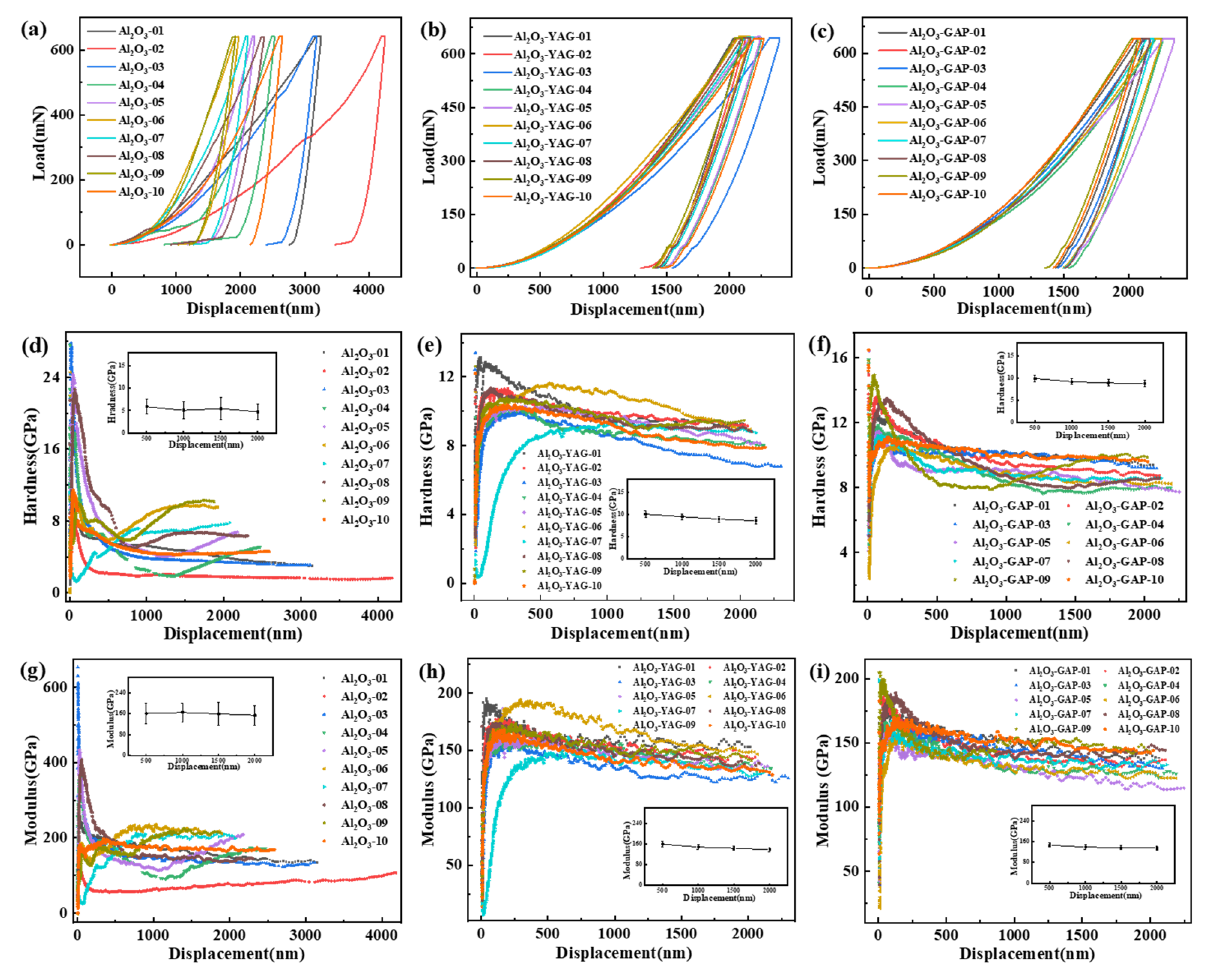
Figure 5. The load–displacement ( a – c ), hardness–displacement ( d – f ) and modulus–displacement ( g – i ) curves of the Al 2 O 3 , Al 2 O 3 -YAG and Al 2 O 3 -GAP coatings. Table 4. The nanoindentation hardness and elastic modulus of several coatings for different nanoin- dentation